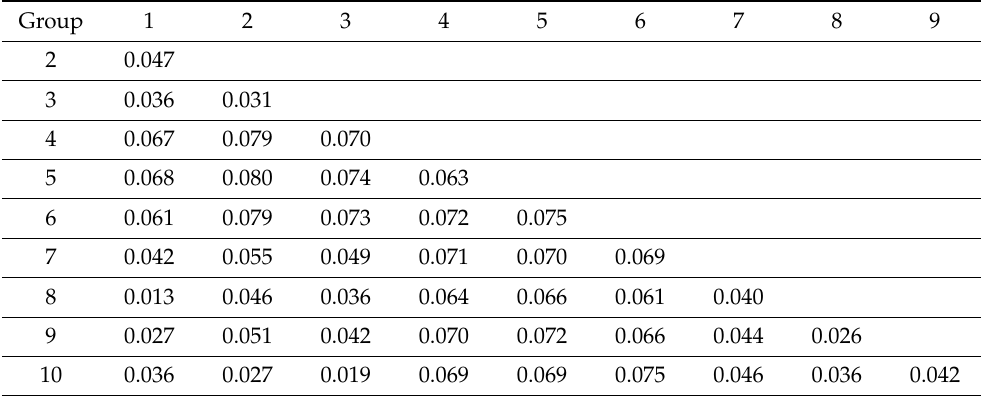
Table 1. Uncorrected pairwise differences between lineages of marsh frogs of P. ridibundus complex based on ND2 gene